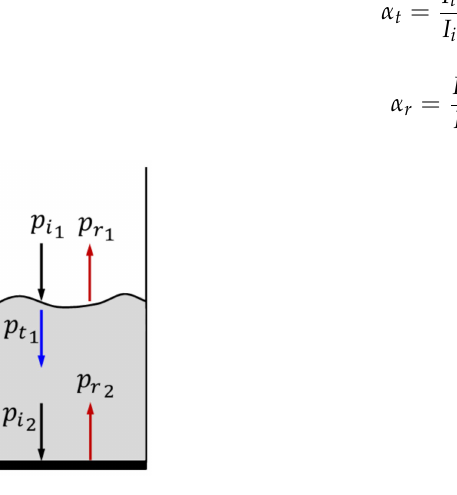
Figure 3. Incidence, reflection and transmission of acoustic waves from the bed interface and the